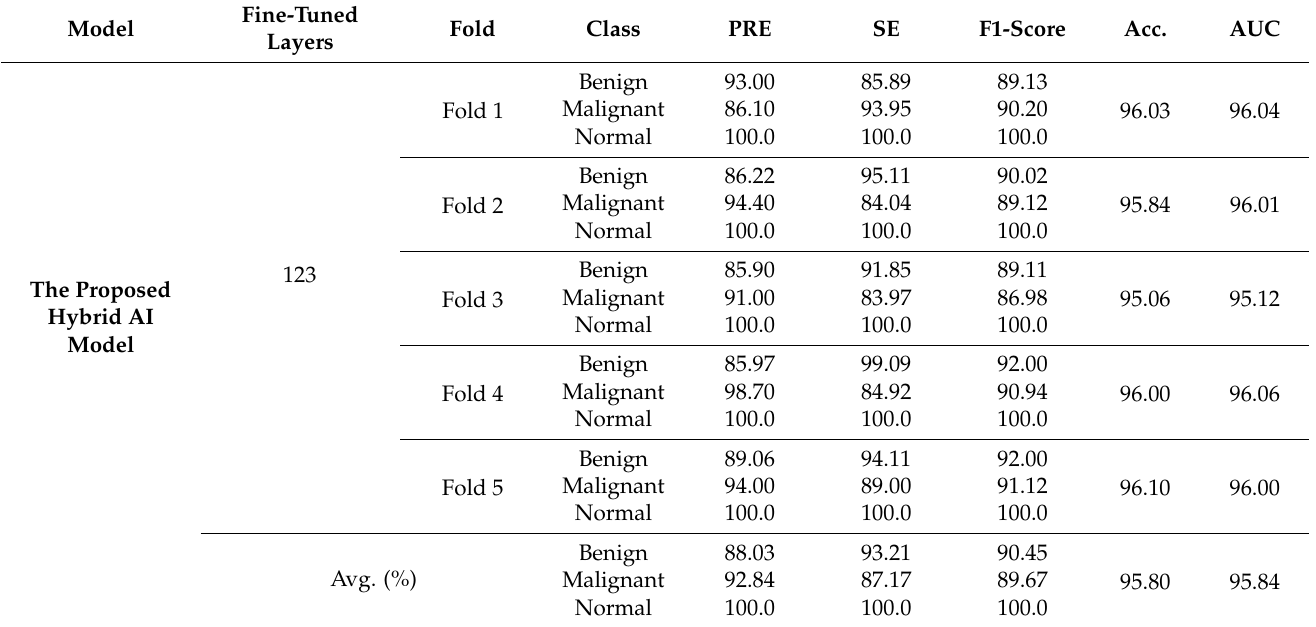
Table 11. Scenario B evaluation results using dataset 4: evaluation metrics for the proposed hybrid AI model (ResNet50 and ViT) over five-fold tests.